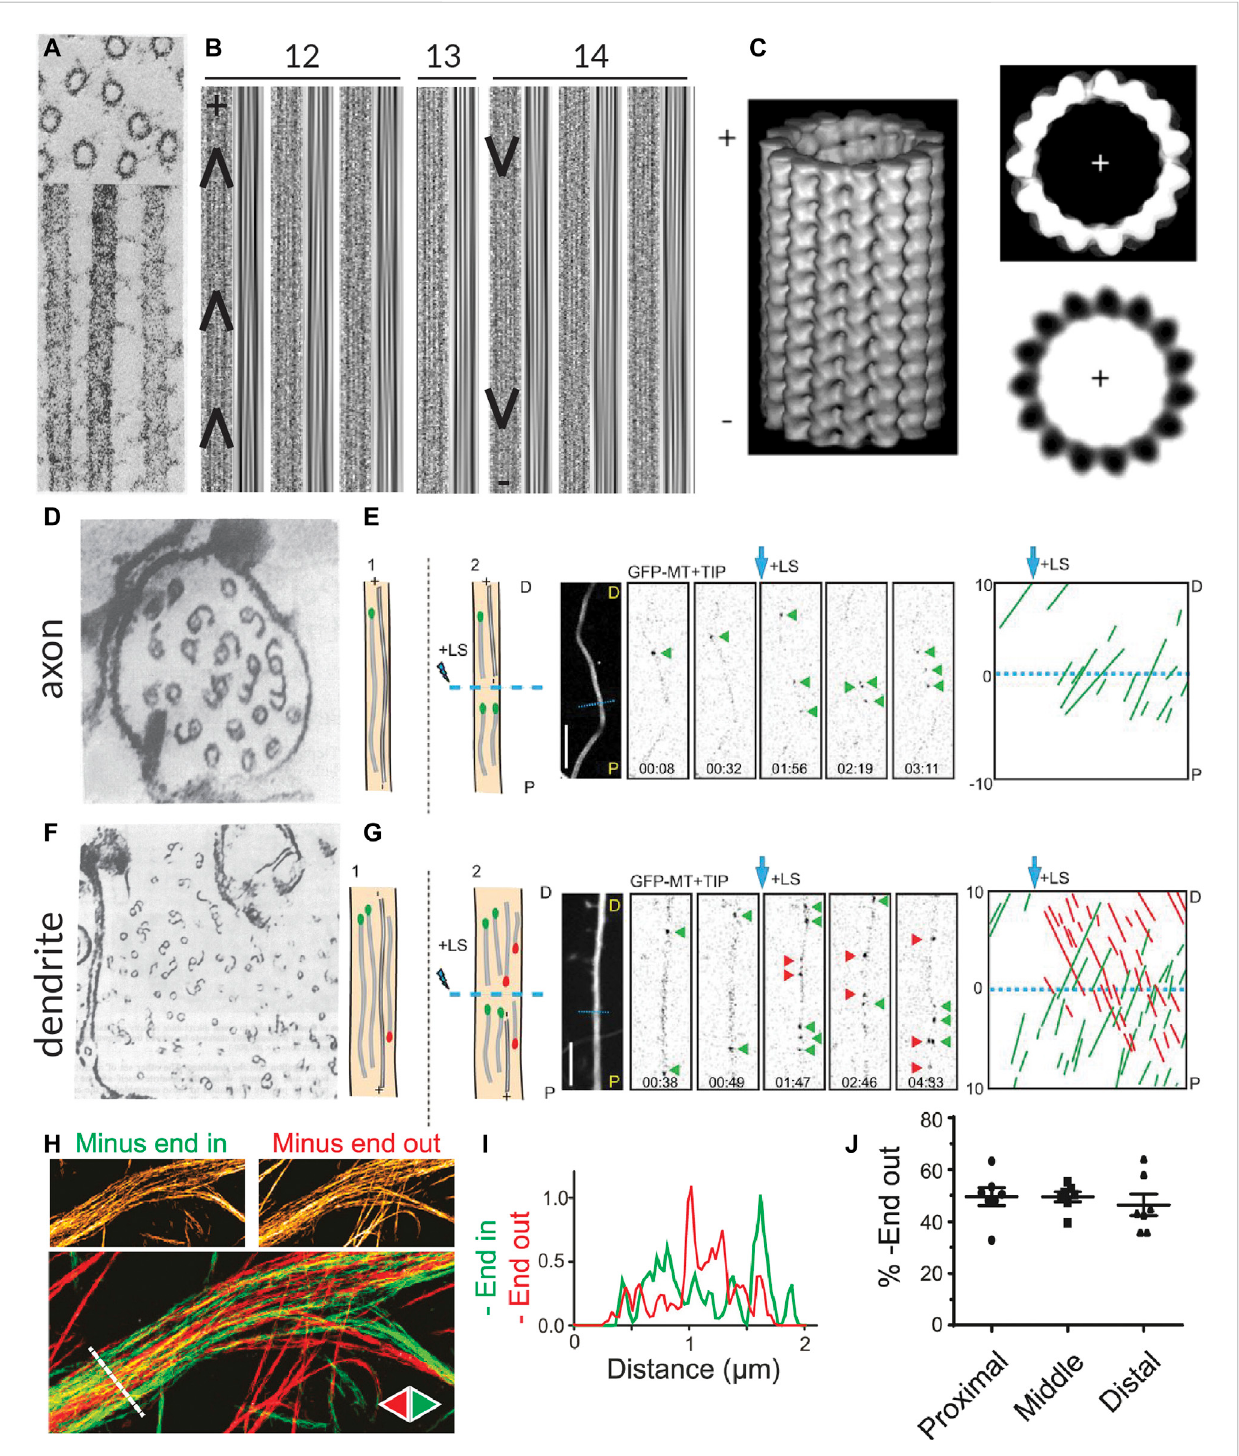
Methods for visualizing the polarity of (neuronal) microtubules. (A) Decoration of microtubules polymerized from porcine brain tissue with dynein heavy chain fragments. Note the uniform tilt of the dynein fragments along the length of a given microtubule, indicating the structural polarity of the fi laments. Taken from (Murphy and Borisy, 1975). (B) The moiré patterns from microtubules grown from puri fi ed calf brain tubulin and nucleated off of isolated centrosomes such that their polarity is known. All microtubules oriented plus-end-up. Chevrons drawn in to help visualize the chevrons in the moiré patterns. When microtubules have 13 proto fi laments they run parallel to the microtubule axis, but when they have another number of proto fi laments, they have a supertwist, producing arrowheads of a uniform direction; however, the direction of these arrowheads depends on the number of proto fi laments, which dictates the handedness of the supertwist. Taken from (Chrétien et al., 1996). (C) A 3D reconstruction of a 15 proto fi lament microtubule, as well as a corresponding axial view and a projection of a thin slice from this reconstruction, both viewed from the plus- end towards the minus-end. Note that the tubulin monomers are tilted counter-clockwise when viewed from this end. This tilt is independent of